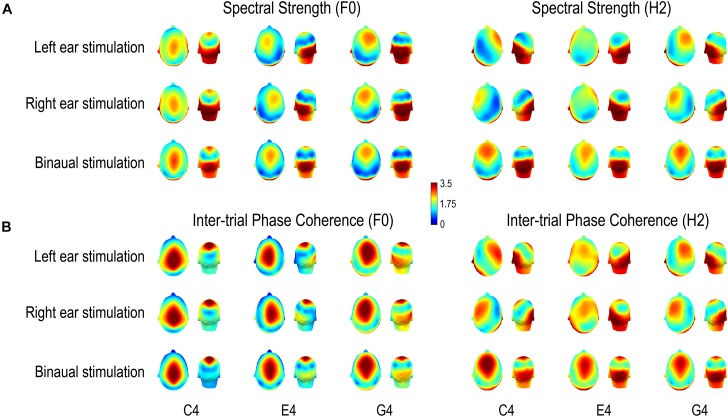
Scalp distributions of (A) FFR spectral strength and (B) inter-trial phase coherence. Both spectral strength and phase coherence are of large values in two regions, one temporo-occipital and one central-frontal, except that for the F0 component of the FFR to C4, the phase coherence is weak in the temporo-occipital region and for the H2 component of the FFR to monaural E4, the spectral strength is weak in the central-frontal region. Importantly, scalp distributions of both FFR measures vary with stimulus F0 for both F0 and H2 components of FFRs to all three complex tones, supporting a varying FFR source configuration with stimulus F0. For the F0 component, the area where the FFR measures are of large values in the central-frontal region moves from vertex forward to frontal regions with increasing stimulus F0; it stays frontal for the H2 component across stimulus F0s. For both F0 and H2 components, the laterality of the area where the FFR measures are of large values in the temporo-occipital region changes with stimulus F0. Note that normalized data are displayed.